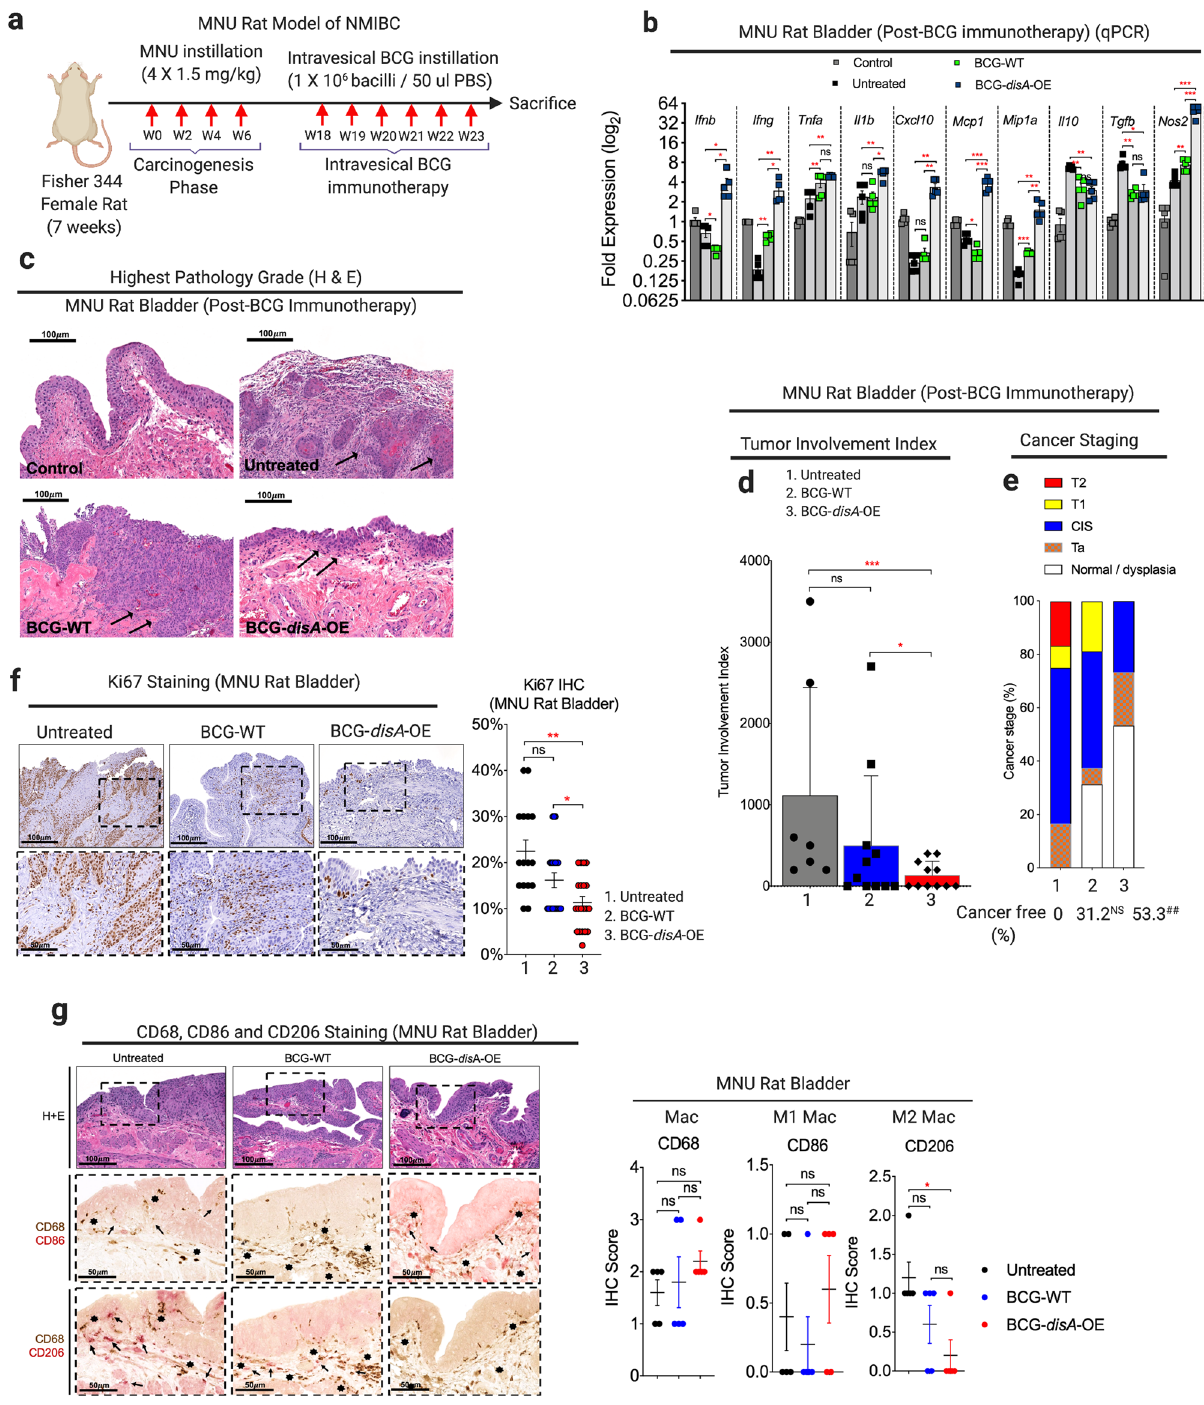
Fig. 5 BCG- disA -OE elicits improved antitumor ef fi cacy over BCG-WT in the orthotopic carcinogen-induced rat model of urothelial cancer. a Schematic diagram of the MNU rat model of NMIBC. b mRNA levels for pro-in fl ammatory cytokines ( Ifnb , Ifng , Tnfa , and Il1b ), regulatory chemokines ( Cxcl10 , Mcp1 , and Mip1a ), immunosuppressive M2-like macrophage cytokines ( Il10 and Tgfb ) and M1-like tumoricidal effectors ( Nos2 ) in whole bladders at necropsy (wk 23) measured by qRT-PCR relative to GAPDH ( n = 5 animals/group). c Representative H&E staining showing highest pathology grade for each group [control, untreated MNU bladder, BCG-WT (Past and Tice), and BCG- disA -OE (Past and Tice) ( n = 12 – 16 animals/group)]. d Tumor involvement values at necropsy (7 – 11 animals/group). e Highest tumor stage at necropsy. f Representative immunohistochemistry and bar graph of rat bladder tissue at necropsy stained for Ki67 ( n = 17 – 22 animals). g Representative immunohistochemical co-staining and line graph for CD68 (brown), CD86 (M1-like macrophages; red) and CD206 (M2-like macrophages; red) in rat bladder tissues at necropsy ( n = 5 animals per group). Data are presented as mean values ± S.E.M. (qRT-PCR) or mean values ± S.D. (tumor involvement index, Ki67 staining and IHC scores). Statistical analyses done using two-tailed Student ’ s t- test (* P < 0.05, ** P < 0.01, *** P < 0.001, **** P < 0.0001) (qRT-PCR) and one-way ANOVA (## P < 0.01).